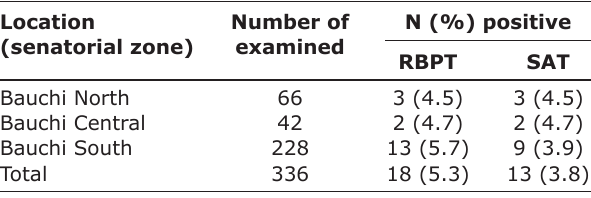
Table-3: Seroprevalence of bovine brucellosis in Bauchi State, Nigeria based on location.